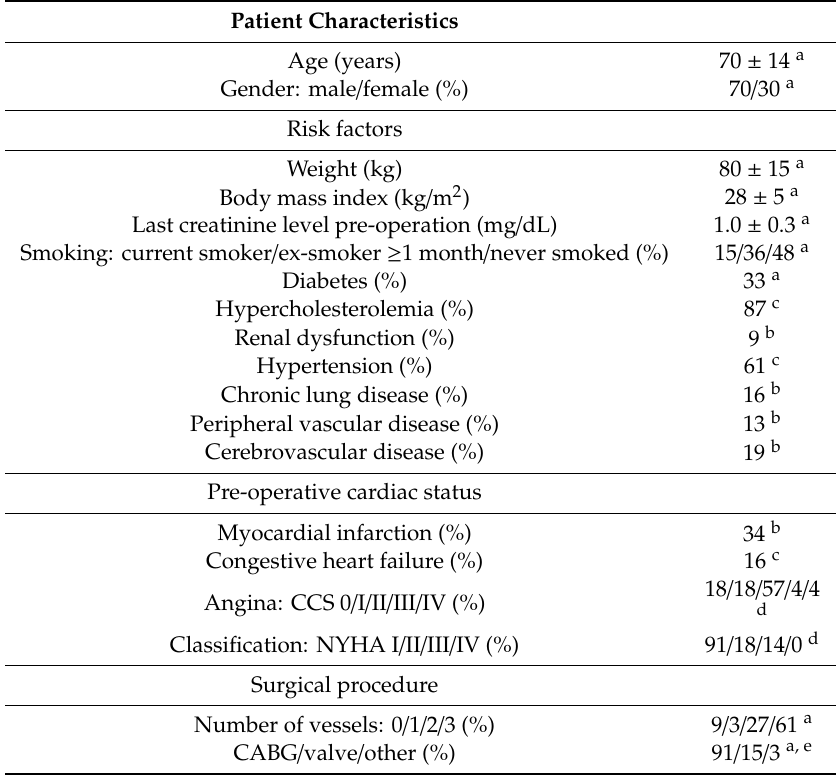
Table 2. Patient